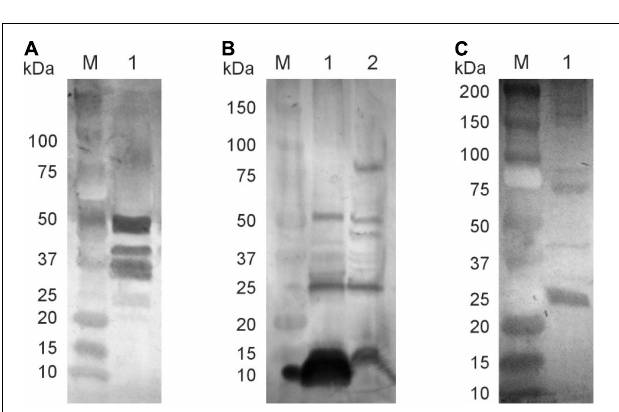
FIGURE 6 | Specificity of elicited antibodies. Phage particles, cellular proteins, and E1 HCV protein were separated on SDS-PAGE gel and subjected to Western blot analysis. Reactivity of rabbit sera obtained after immunization with phagemid pBSKS:: (cid:56) 6fm(ST) with S. enterica ser. Typhimurium proteins ( A , lane 1); Reactivity of rabbit sera elicited after immunization with phagemid pBSKS:: (cid:56) 6fm(Hin) with phagemid proteins ( B , lane 1) and H. influenzae Rd30 cell proteins ( B , lane 2); Reactivity of rabbit sera elicited after immunization with phagemid pBSKS:: (cid:56) 6fm(ST) propagated in S. enterica ser. Typhimurium cells carrying plasmid pE1 HCV with commercial E1 HCV protein ( C , lane 1). Lanes marked with M indicate molecular weight standards.